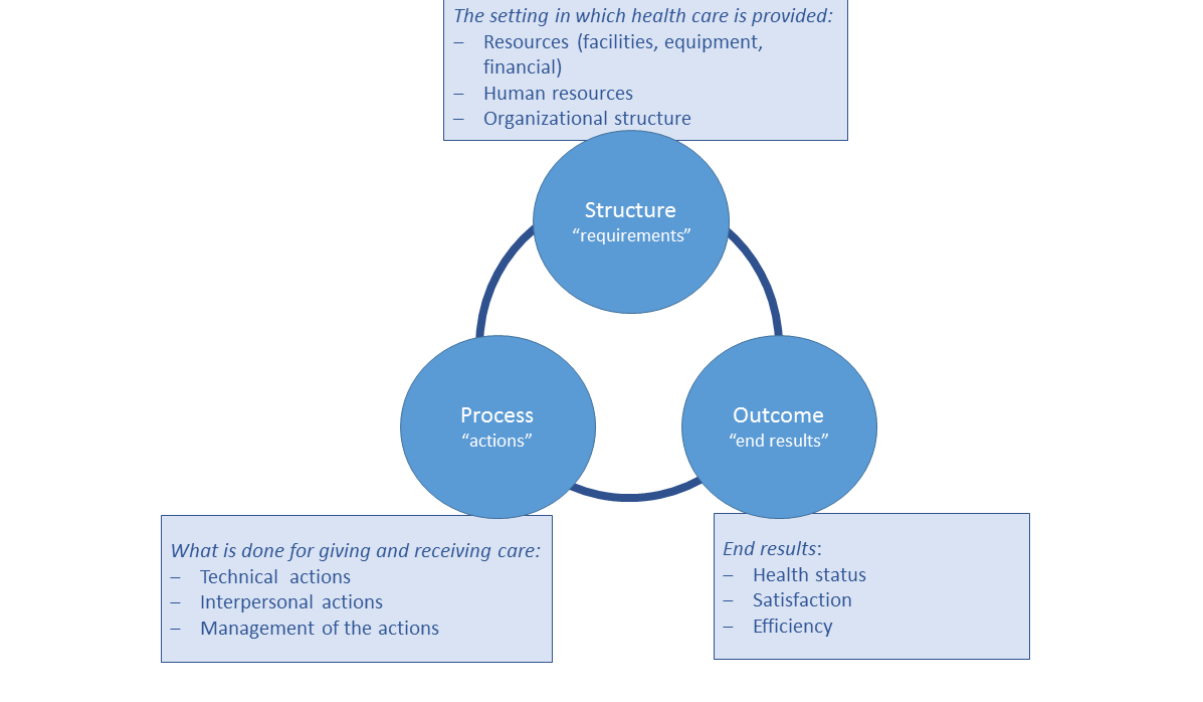
adjustments are described in the themes presented in Textbox 1. The adjustments to the SPO framework are shown in Figure